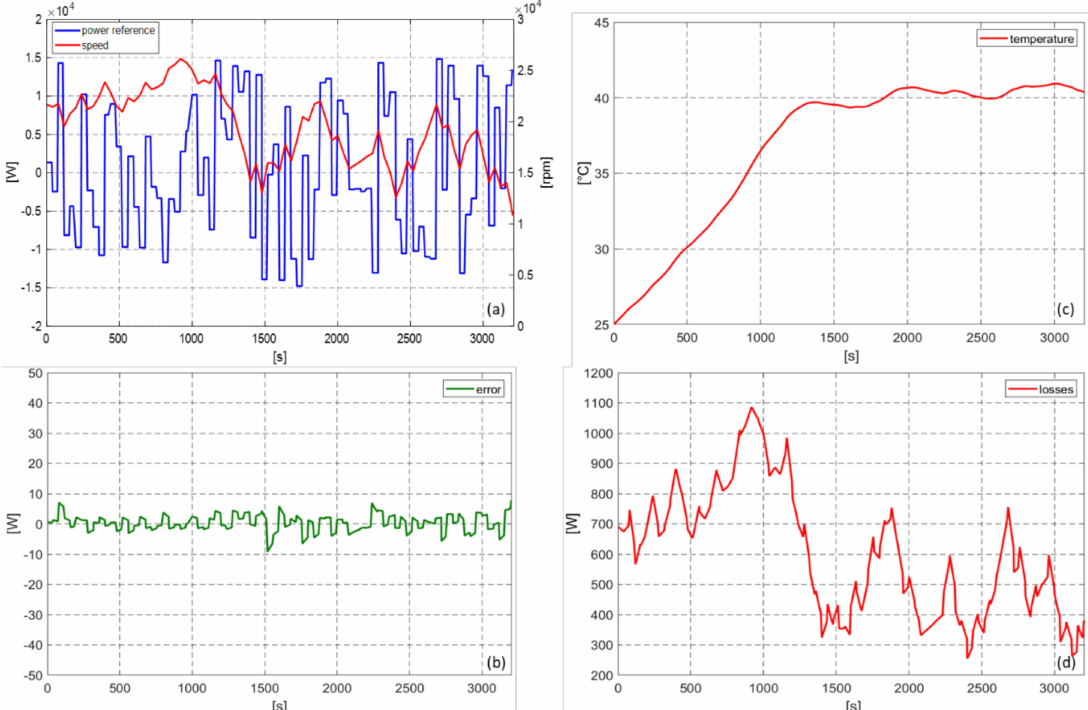
Figure 12. Simulation results related to the application of a test reference power; ( a ): output power reference and FWR speed; ( b ): error between reference and actual output power; ( c ): EM internal temperature; ( d ): EM